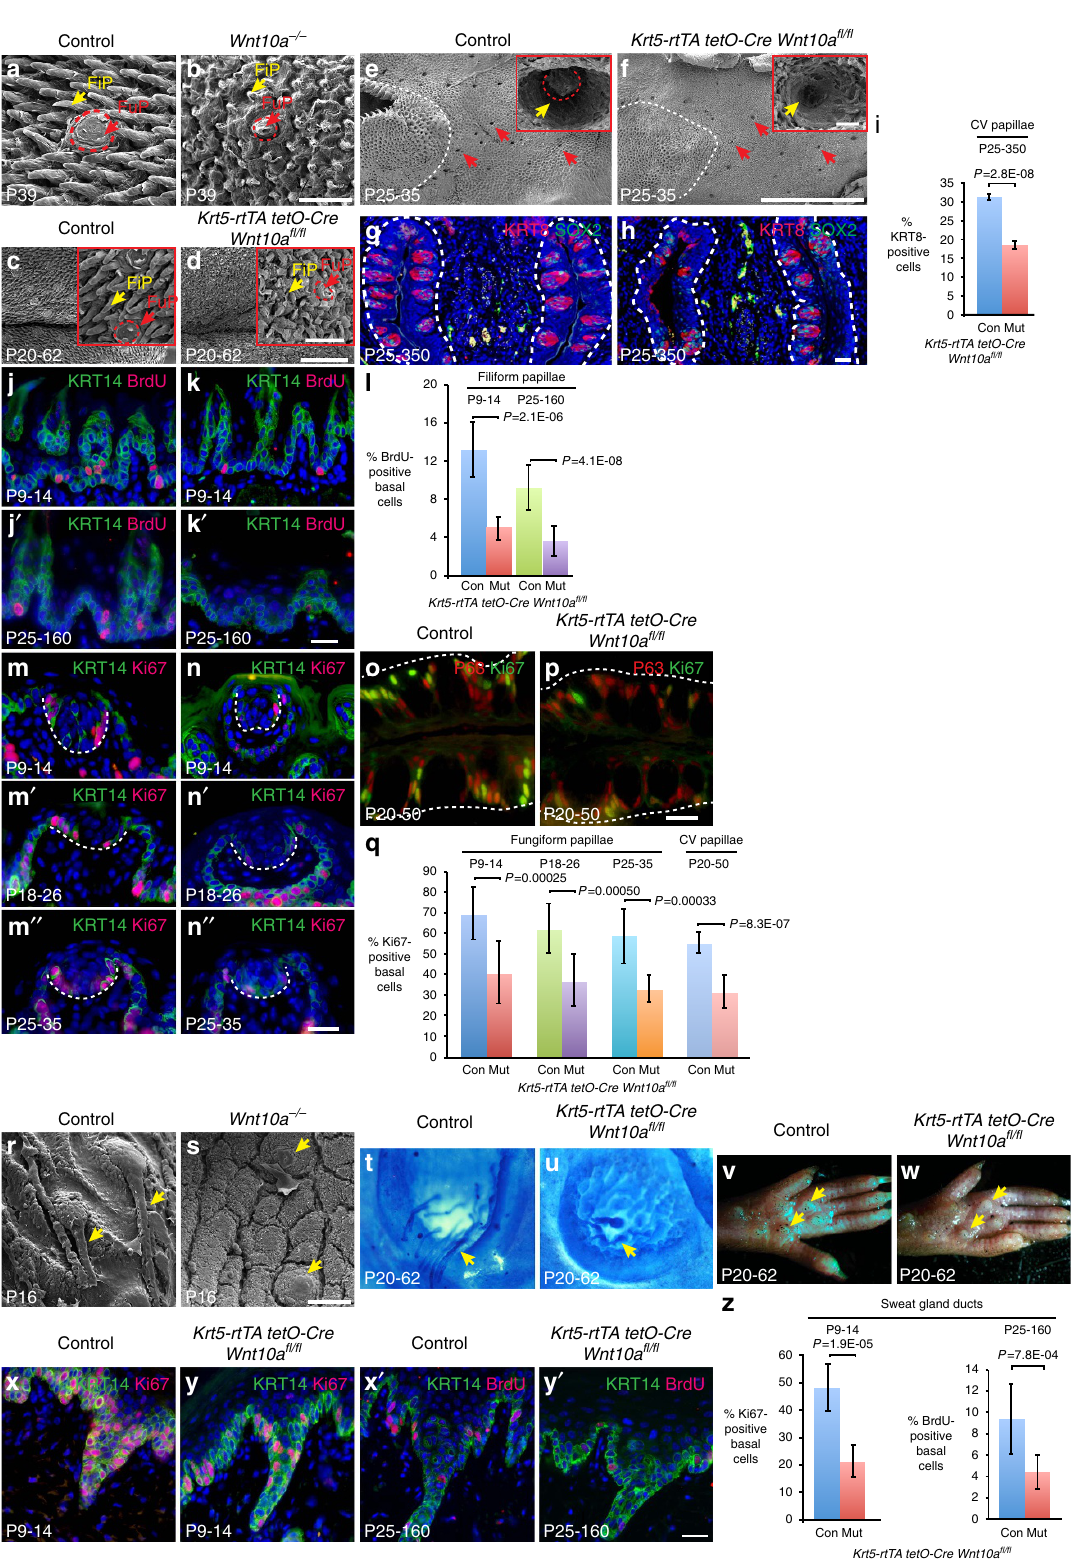
Supplementary Fig. 3v,w,z), similar to the effects of inducible b -catenin deletion 16 . Basal proliferation was also reduced in fungiform and circumvallate TBs (Fig.